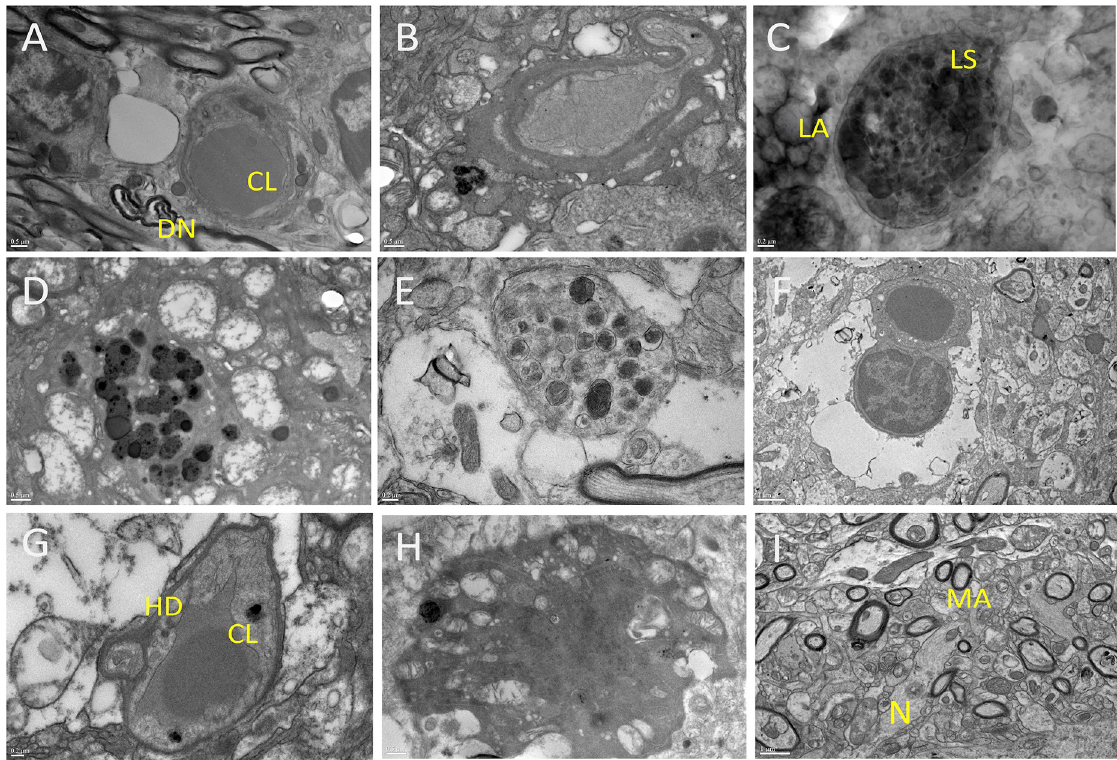
Fig 6. TEM of 12-month-old HSHA hippocampi. (A) depicts a CL, with adjacent lipid vesicles, which were common adjacent to DNs; (B) shows a distorted capillary, lysosomes adjacent to lipid vesicles and some lipofuscin material; (C) shows significant abundance of LS associated with LAs; (D) shows a lysosome adjacent to extensive neuronal degeneration; (E) shows a dystrophic neurite associated with swollen astrocytes; (F) shows extraordinarily large pericyte projection and swollen astrocytic processes adjacent to lipid infiltrated parenchyma with substantial cellular loss; (G) show commonly observed residual capillaries surrounded by widespread HD; (H) depicts a dark glial cell, widely abundant in HSHA mice but not in aged-matched controls. ( I ) 12-month-old WT hippocampi normal brain parenchyme including MAs and N. Scale bars represent 0.5 μ m for frames A, B, D, H; 0.2 μ m for frames C, E, G; 1 μ m for frames F and I. CL, capillary vessel; DN, dystrophic neuron; HD, cellular debris; HSHA, hepatocyte-specific human amyloid; LA, lipid aggregate; LS, lysosomal activity; MA, myelinated axon; N, neuron; TEM, transmission electron microscopy; WT,